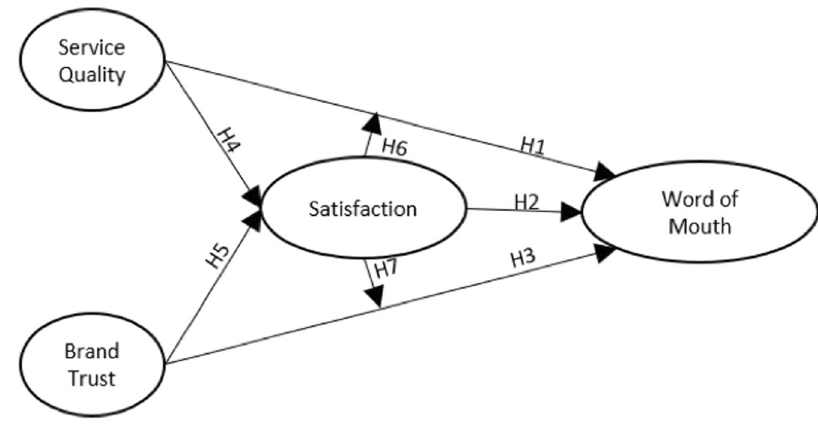
Fig. 1 The research model of antecedents of word of mouth and mediating role of